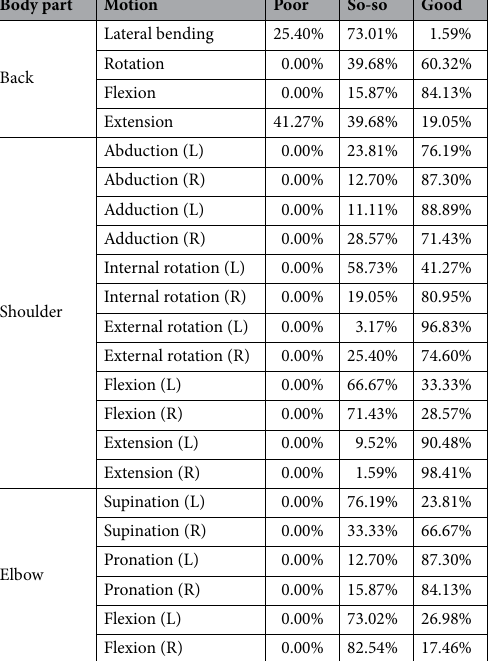
Table 2. Percentage of FFB harvesters with poor, so-so and good posture for different types of back, shoulder and elbow joint motion (n = 8).